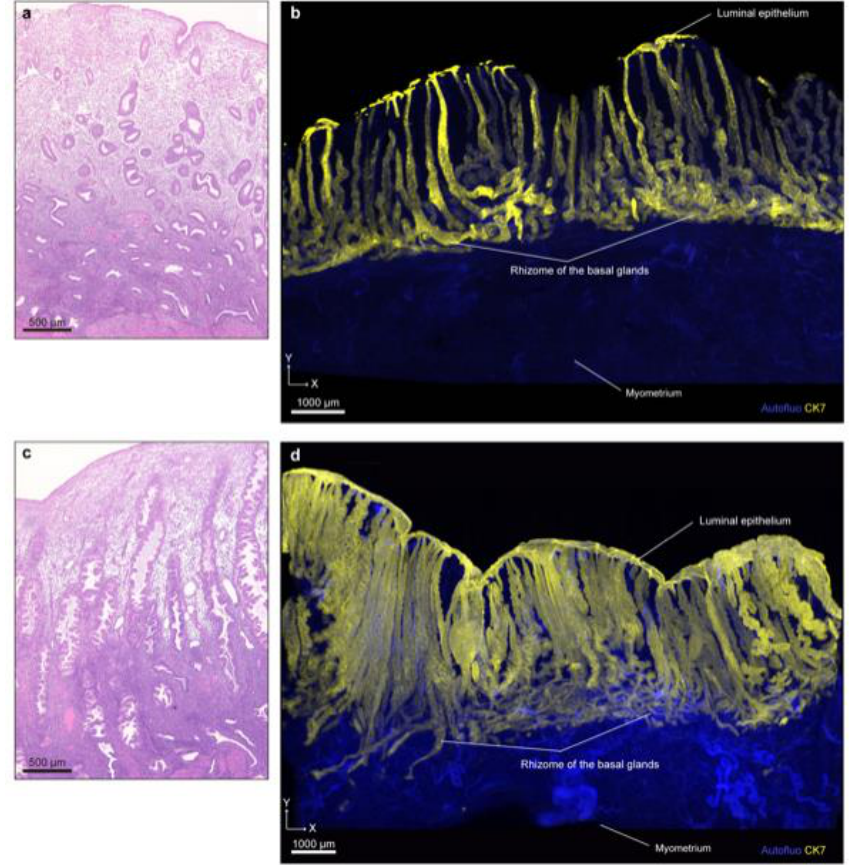
Figure 1. 3D imaging of human uterine tissue using CUBIC. ( a ) Hematoxylin and eosin (H&E)-stained image of formalin-fixed paraffin-embedded (FFPE) endometrial tissue in the proliferative phase (age 46). ( b ) Reconstructed XY section (z = 500 µm) of the same sample shown in panel ( a ) after clearing by CUBIC. ( c ) H&E-stained image of FFPE endometrial tissue in the secretory phase (age 46). ( d ) Reconstructed XY section (z = 1000 µm) of the same sample shown in panel ( c ) after clearing by CUBIC. Images were obtained by LSF microscopy. Autofluorescence was measured by excitation at 488 nm. CK7-expressing endometrial epithelial cells were measured by excitation at 532 nm. Autofluo, autofluorescence; CK7, cytokeratin 7.